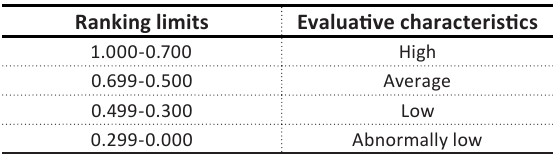
Table 2. Scale of social effectiveness effectometry? Source: Developed by the authors.